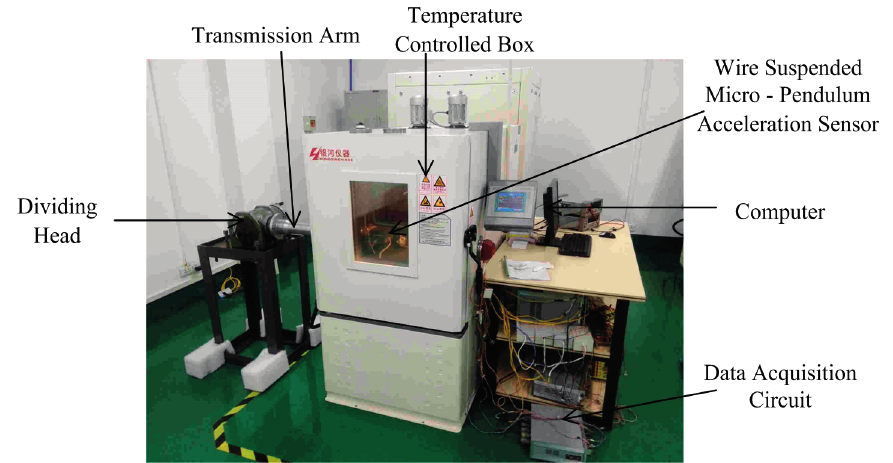
Figure 5. Experimental